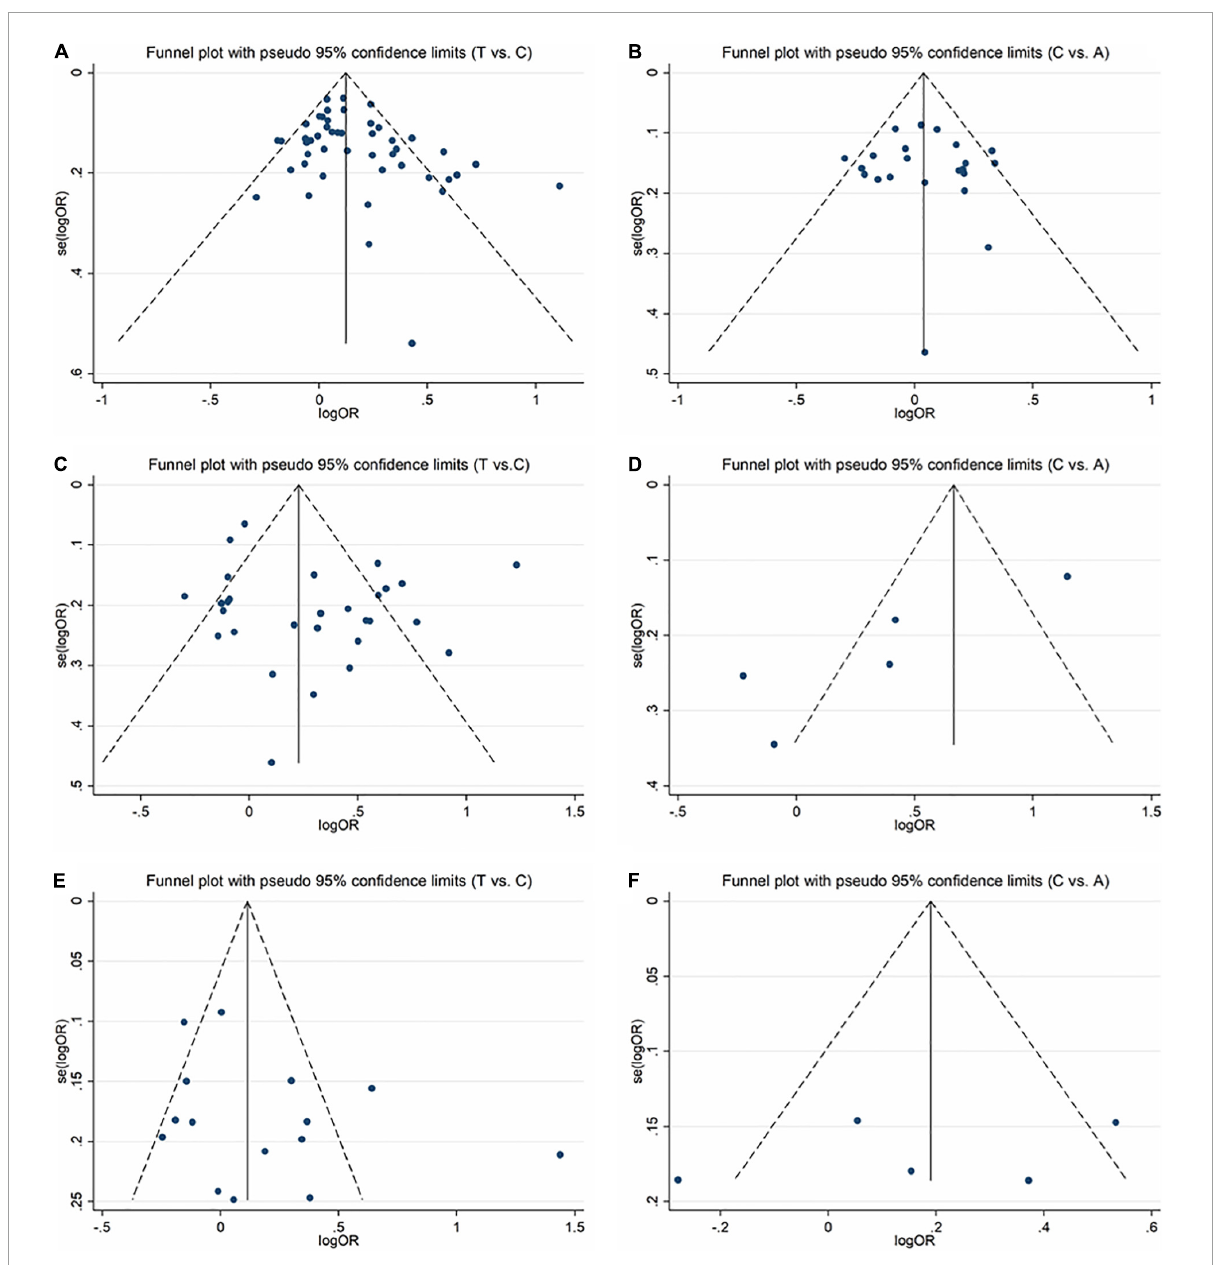
FIGURE8 Funnel plots for assessing the publication bias risk in this meta-analysis. (A) Funnel plot for allele contrast (T vs. C) of C677T polymorphism in SZ. (B) Funnel plot for allele contrast (C vs. A) of A1298C polymorphism in SZ. (C) Funnel plot for allele contrast (T vs. C) of C677T polymorphism in MD. (D) Funnel plot for allele contrast (C vs. A) of A1298C polymorphism in MD. (E) Funnel plot for allele contrast (T vs. C) of C677T polymorphism in BPD. (F) Funnel plot for allele contrast (C vs. A) of A1298C polymorphism in